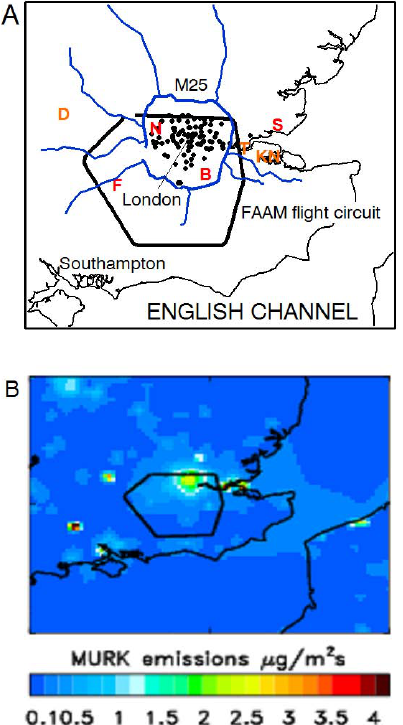
Fig. 1. Maps of south-eastern England showing: (a) location of the major motorway network (blue lines), London Air Quality Net- work observing sites (black circles), the main FAAM London cir- cuit flight track (black line), the locations of three large coal-fired power stations (orange letters: “D” = Didcot; “T” = Tillbury; “KN” = Kings North) and airfields used for missed approaches (red let- ters: “N” = Northolt; “F” = Farnborough; “B” = Biggin Hill; “S” = Southend) and (b) “MURK” emissions (a generic term for emis- sions that drive the aerosol field in the UK4 model